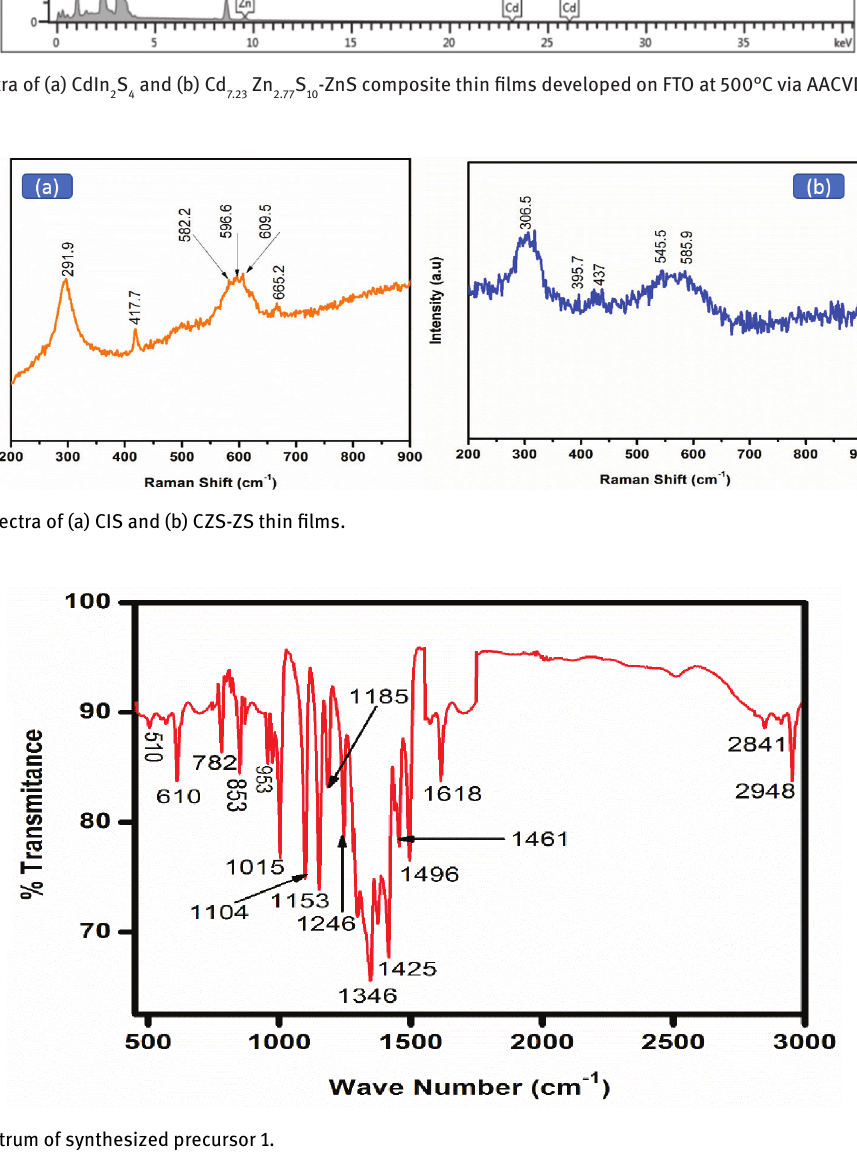
Figure A5: FT-IR spectrum of synthesized precursor